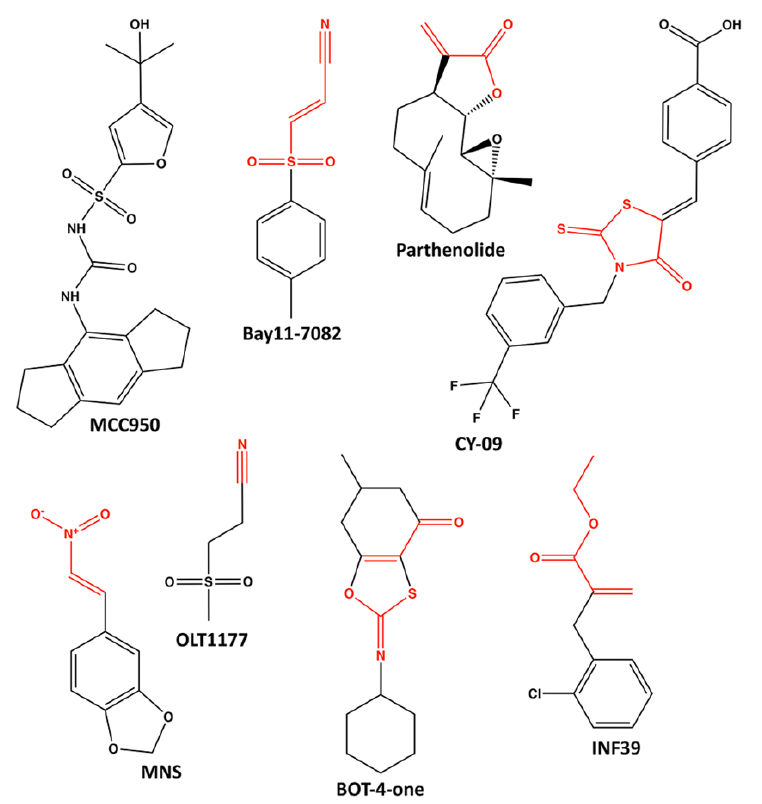
Figure 6. Small molecule inhibitors targeting the ATPase Activity of NLRP3. Chemical structures of NLRP3 Inhibitors which target the ATPase activity of NLRP3 are provided. The molecular structures were generated in ChemDraw v19, and the Michael acceptor moiety is coloured in red for electrophilic inhibitors. PubChem Compound Identification Numbers: MCC950, 9910393; parthenolide, 7251185; Bay11-7082, 5353431; CY-09, 75070350; MNS, 672296; OLT1177, 12714644; Bot-4-one, 16129399; and INF39, 69150705.